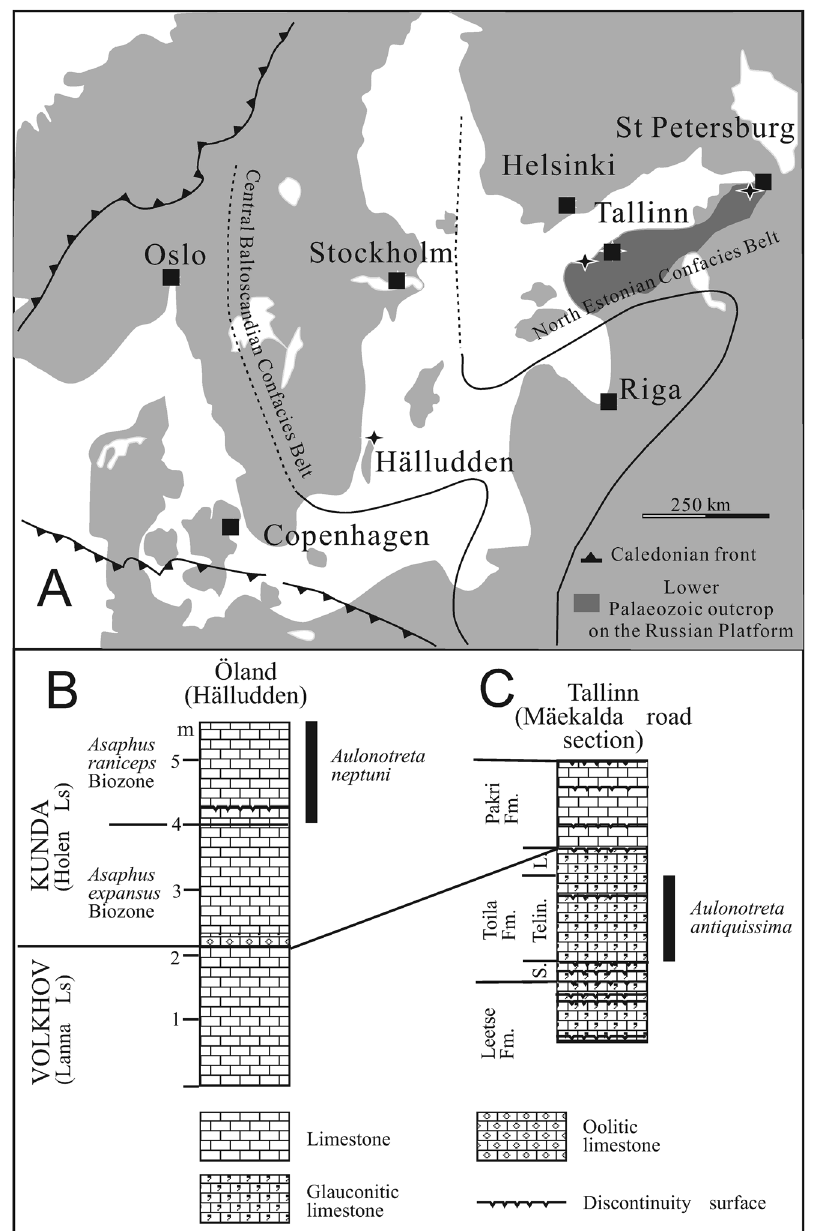
Fig. 1. A , regional overview of the early Palaeozoic on the Russian Platform with the collection sites marked by stars (map after Jaanusson 1976; Kröger et al. 2009, fig. 1); B , simplified lithological column through the Volkhov–Kunda interval in the Hälludden section, Northern Öland (after Jaanusson & Mutvei 1982, fig. 6); C , simplified lithological column through the Volkhov–Kunda interval in the Mäekalda road section, Tallinn (after Viira et al. 2001, fig. 2), S. = Saka Member, Telin. = Telinõmme Member, L. = Lahepere